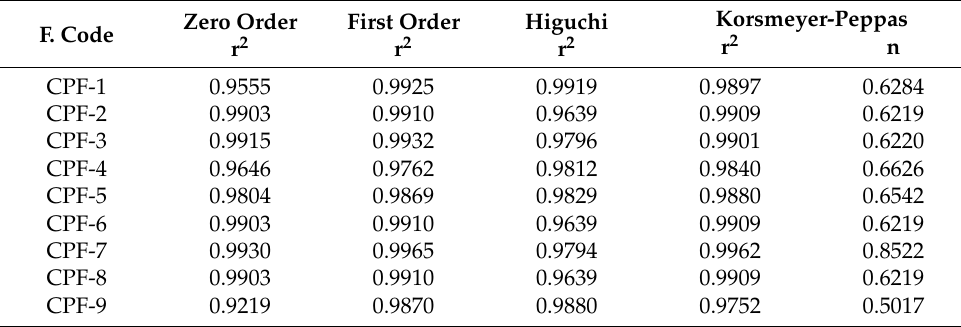
Table 3. Kinetic modeling release of drug from CP/SpScPAA hydrogels. F.